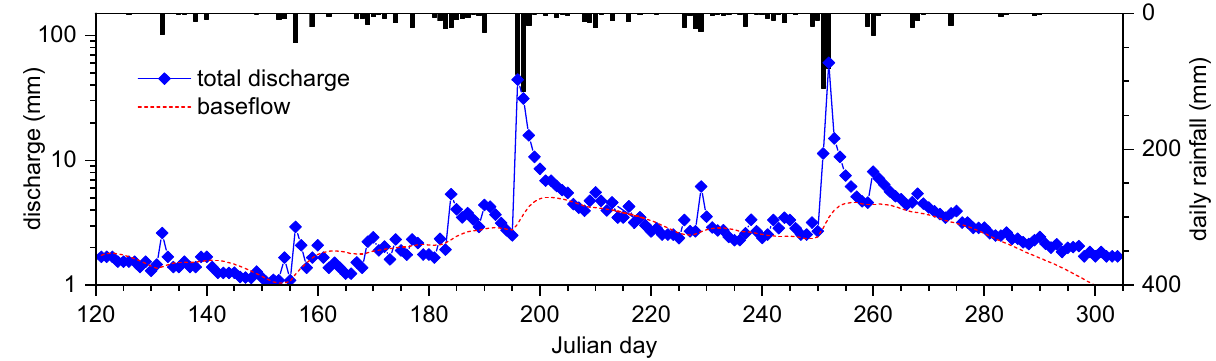
Figure 2. Hydrograph of daily discharge and baseflow during the wet season (May–October) in year 2015.